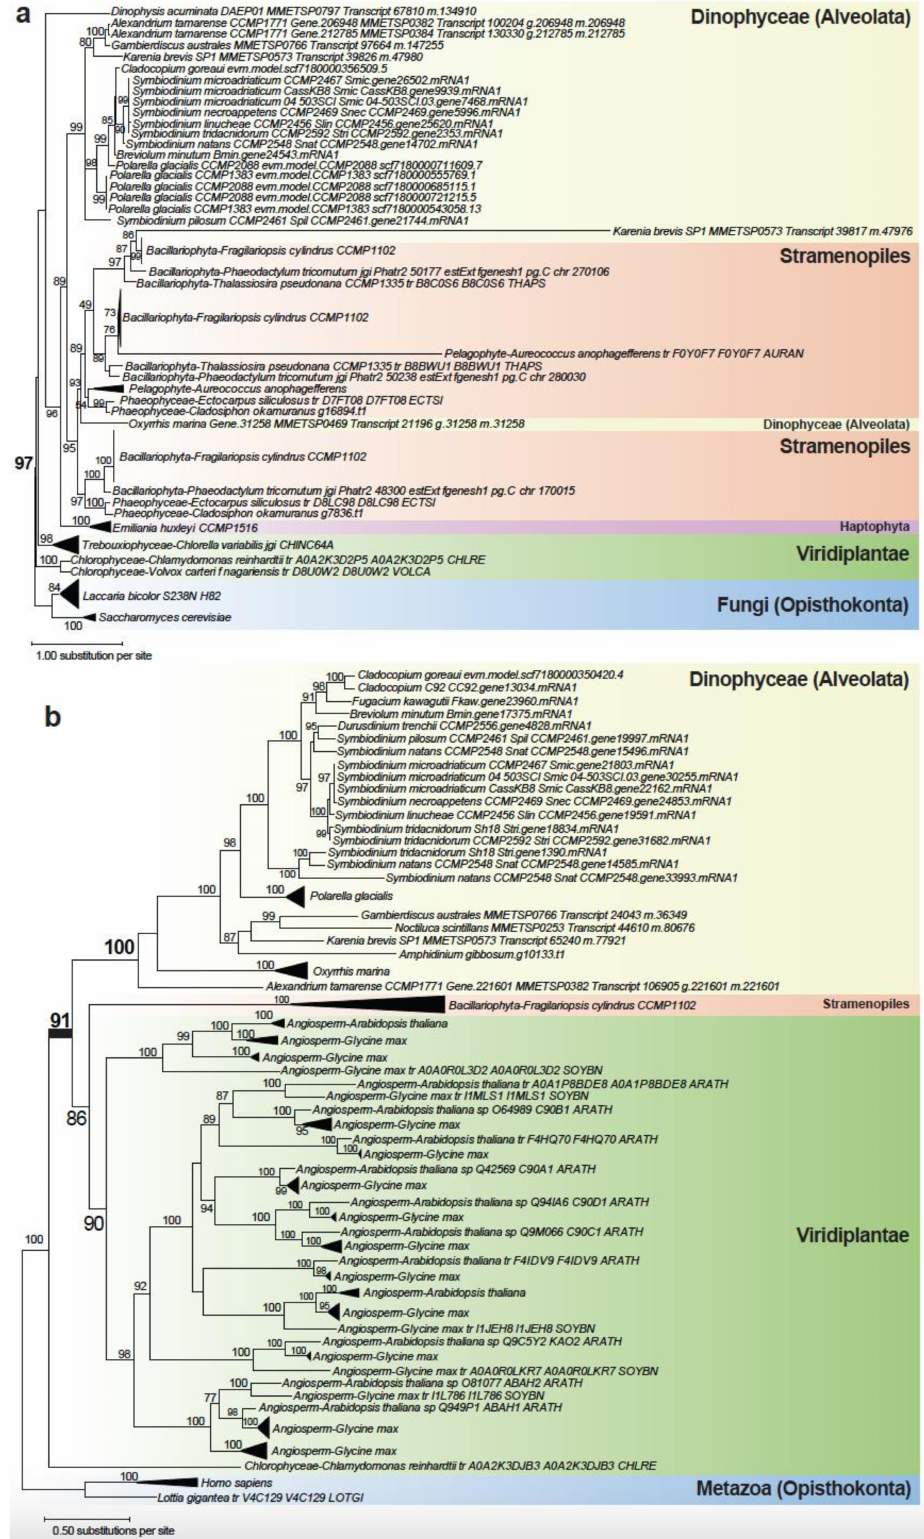
Figure 3. Maximum likelihood trees of ( a ) beta-glucan synthesis-associated protein and ( b ) abscisic acid 8 (cid:48) -hydroxylase, suggesting ancient gene origins from Viridiplantae. The ultrafast bootstrap support of IQ-TREE2 is shown at each internal node; only values ≥ 70% are shown. Unit of branch length is the number of substitutions per